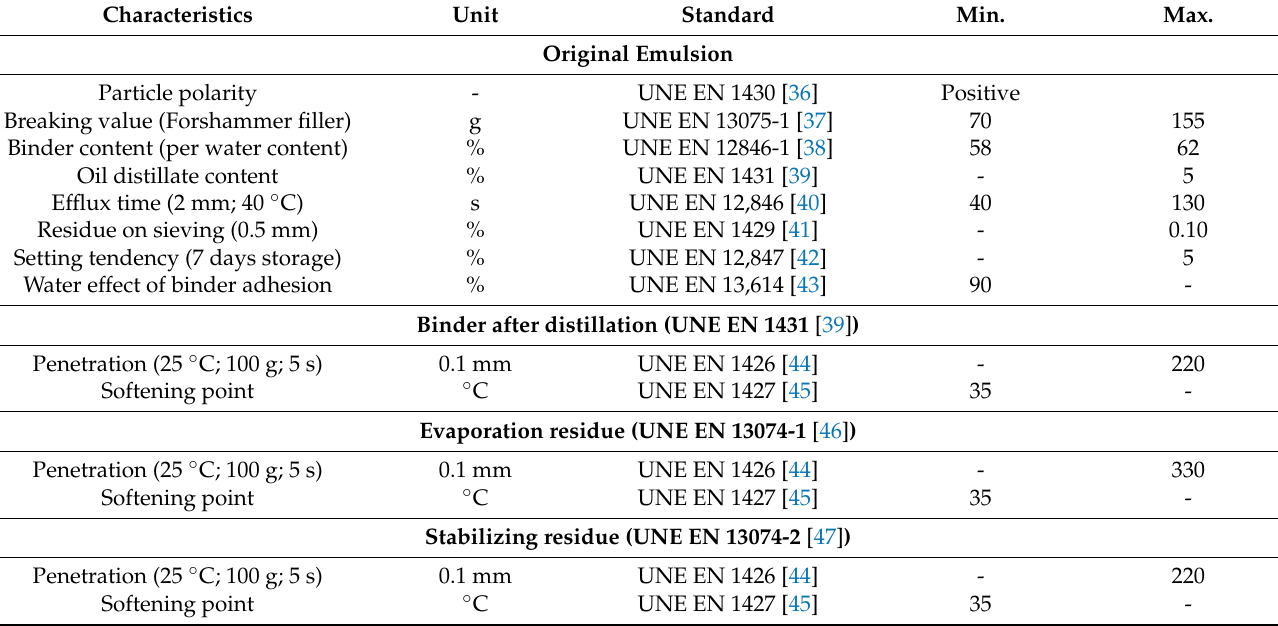
Table 3. Technical details of the bitumen emulsion C60BF3 MBA